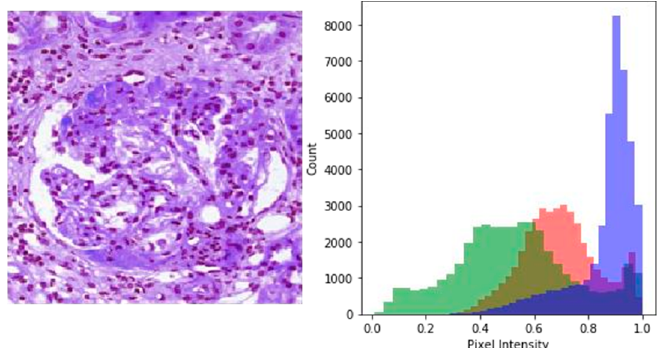
Figure 4. Pixel intensity of images.